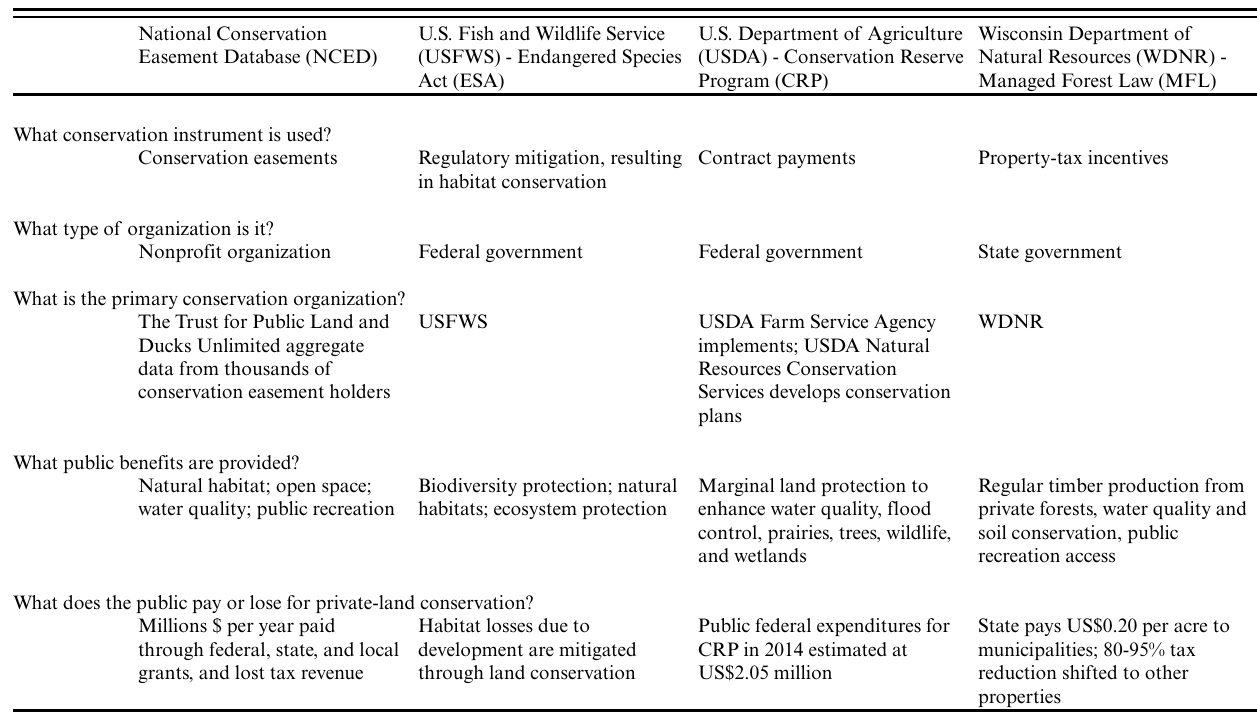
Table 1 . Characteristics of the four private-land conservation